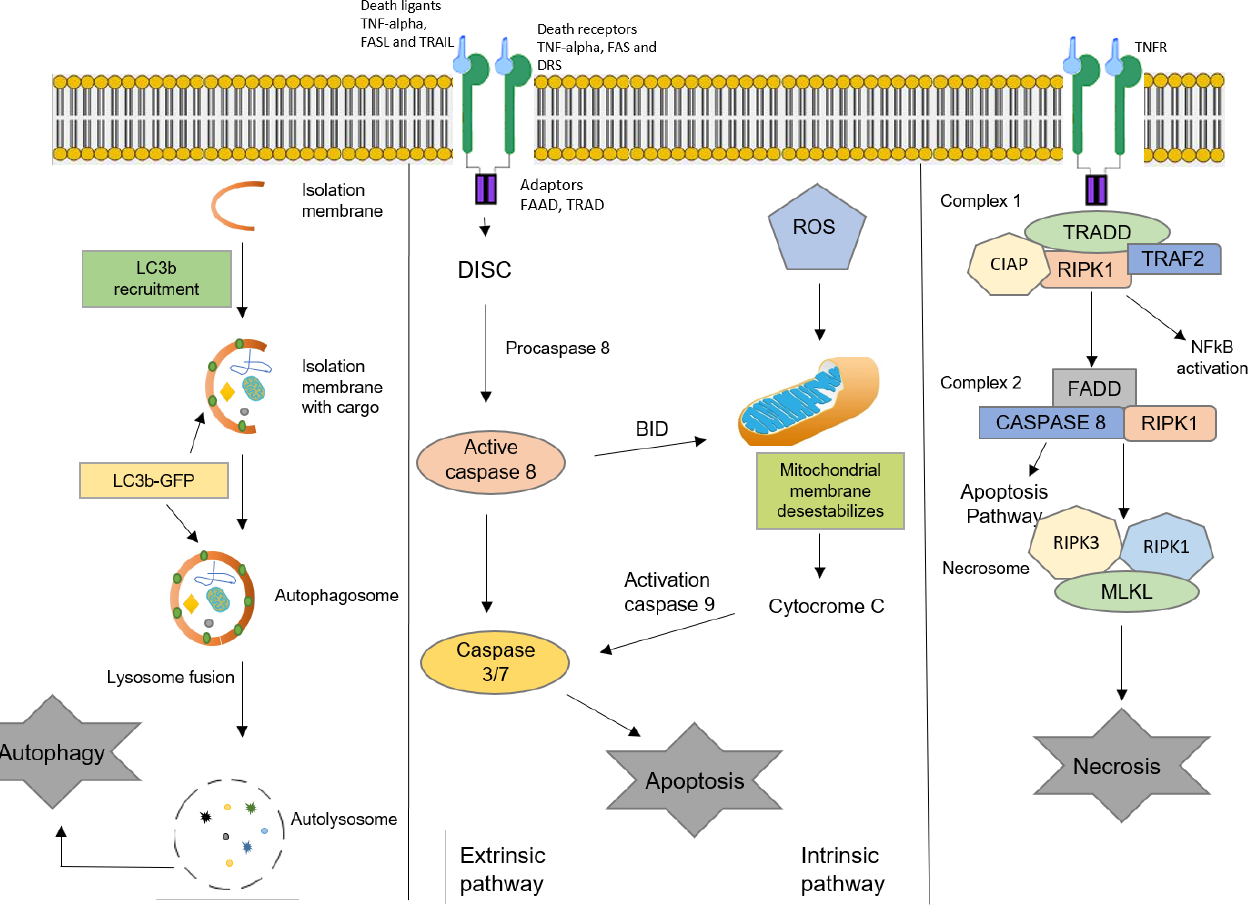
Figure 3. Schematic representation of the three main types of cell death: autophagy, apoptosis, and necrosis. TNF (tumor necrosis factor); FAS (CD95); FAS-L (CD95-ligand); TRAIL (TNF-related apoptosis-inducing ligand); TNFR (TNF receptor); ROS (reactive oxygen species); FADD (Fas-associated death domain); TRADD (TNFR-associated death domain); RIPK (receptor-interacting protein kinase); MLKL (mixed lineage kinase domain-like protein); DISC (death-inducing signaling complex).